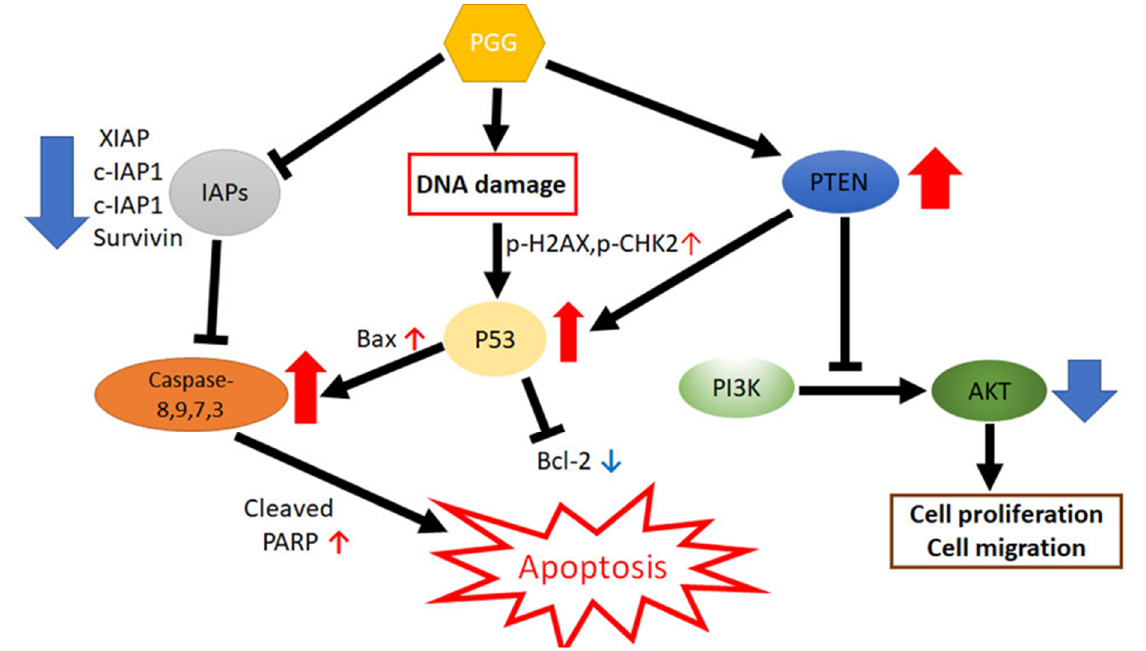
Figure 8. Molecular mechanisms of PGG induced apoptosis via the activation of DNA damage proteins such as p-CHK2, p-γH2AX and p53.